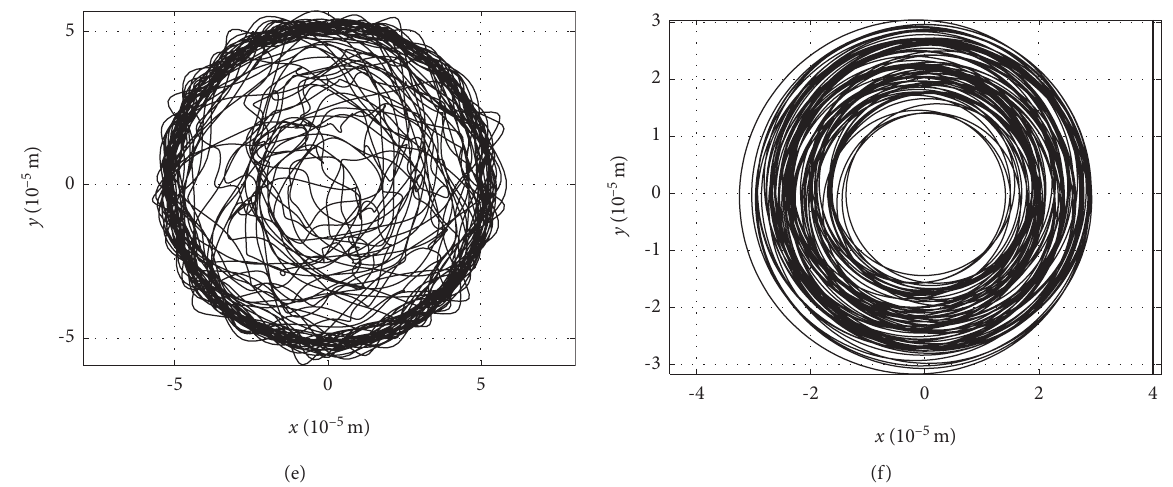
Figure 16: Orbit of disk 4 with rub-impact during level flight. (a) 220rad/s. (b) 226 rad/s. (c) 236rad/s. (d) 252rad/s. (e) 256rad/s. (f)